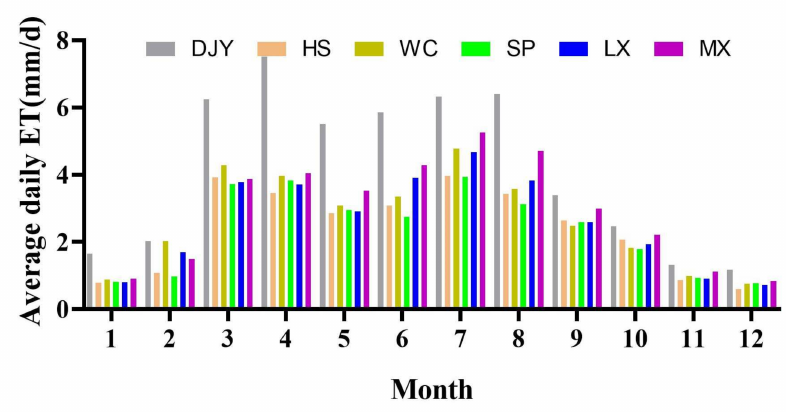
Figure 9. The sum of the average daily ET for each county in 12 months. In the six counties, DJY had the highest average daily ET (6.42 mm/d) in spring.